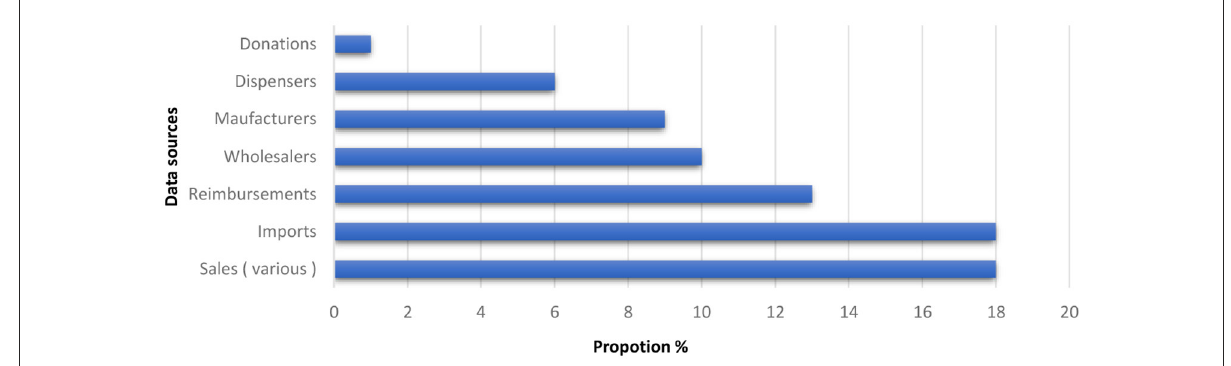
FIGURE1 National estimates of antimicrobial consumption in 65 countries and areas (Organization,